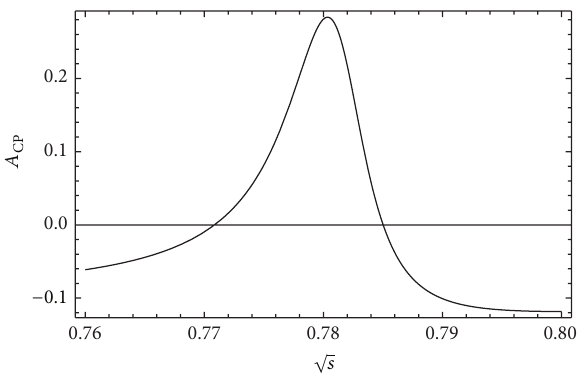
Figure 1: Plot of 𝐴 as a function of √𝑠 corresponding to central CP parametervaluesofCKMmatrixelementsfor 𝐵 𝜋 + 𝜋 − 𝜋 + 𝜋 − .